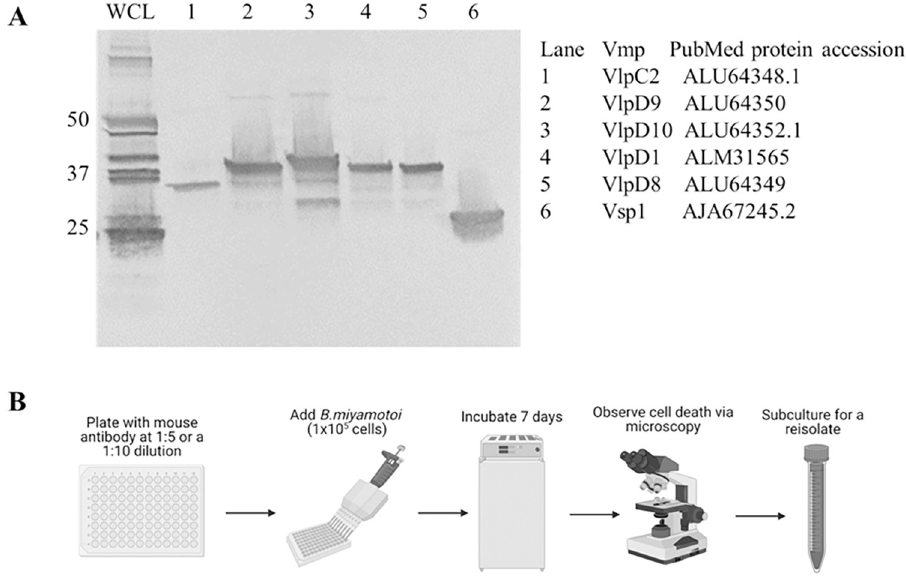
Fig 2. Polyclonal anti- B . miyamotoi reactivity and use in killing assay. A) IgG immunoblot of mouse polyclonal anti- B . miyamotoi LB-2001 antiserum against B . miyamotoi LB-2001 whole cell lysate (WCL) and recombinant Vlps. Molecular mass is indicated on the left by kDa. Recombinant proteins in lanes 1–6 are identified right of the panel. B) Step by step illustration of the antibody selection killing assay